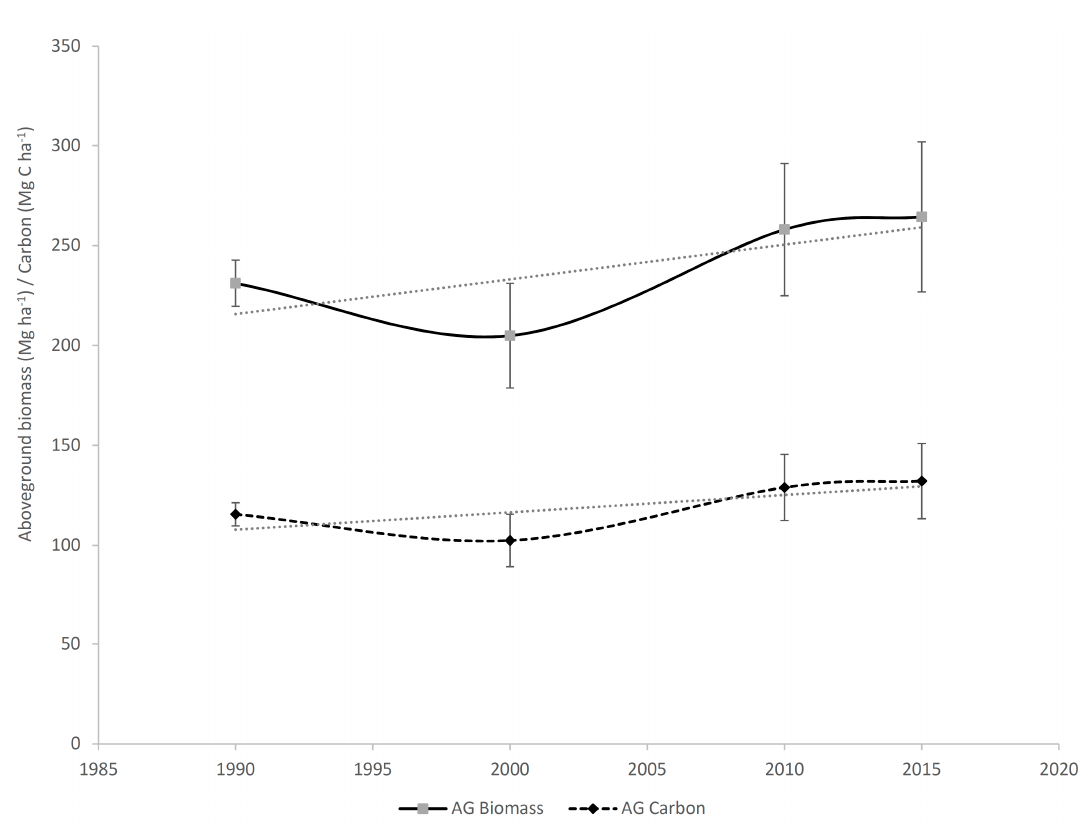
Figure 5. Temporal dynamics of AGB (solid lines) and carbon (dashed line) in the CFR forests. The carbon corresponds to 50% of AGB. Bars indicate the standard error or the mean for each year. A general linear trend is provided.